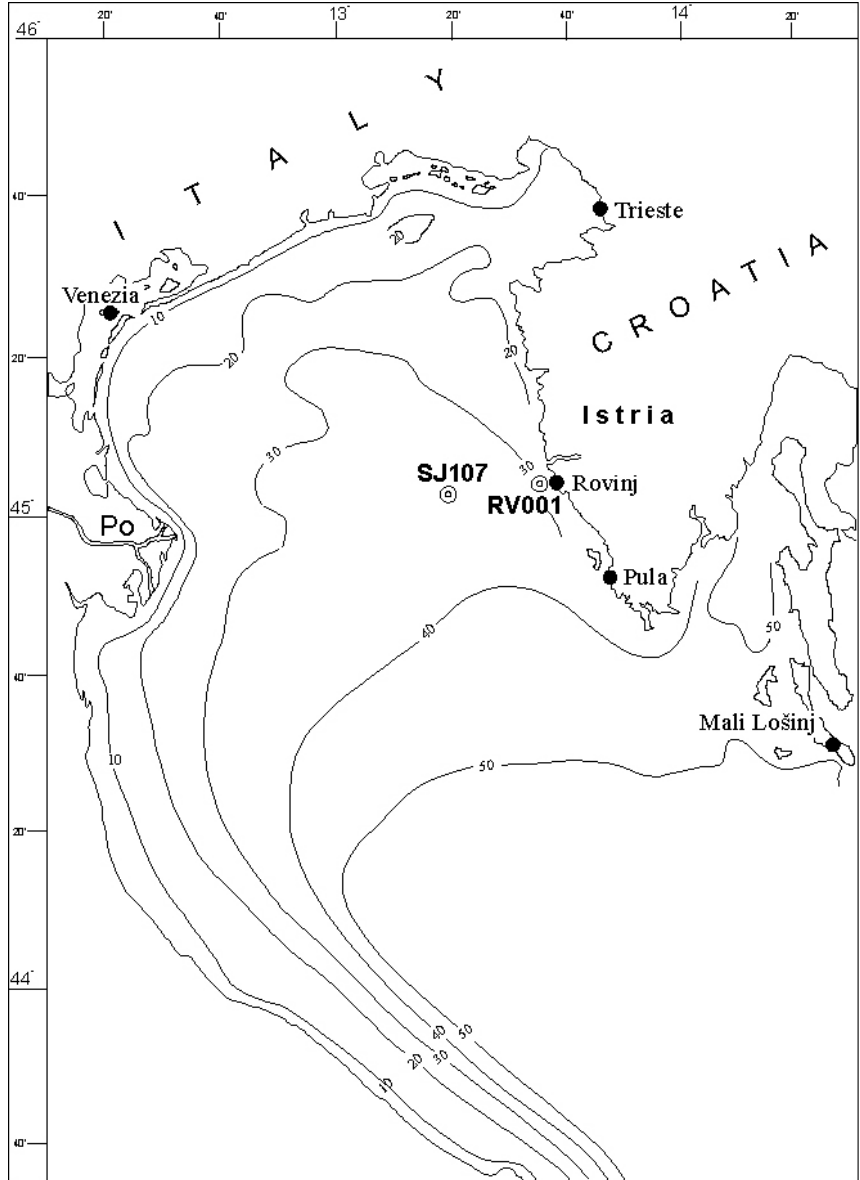
Fig. 1. The northern Adriatic with the oceanographic stations and bathymetric